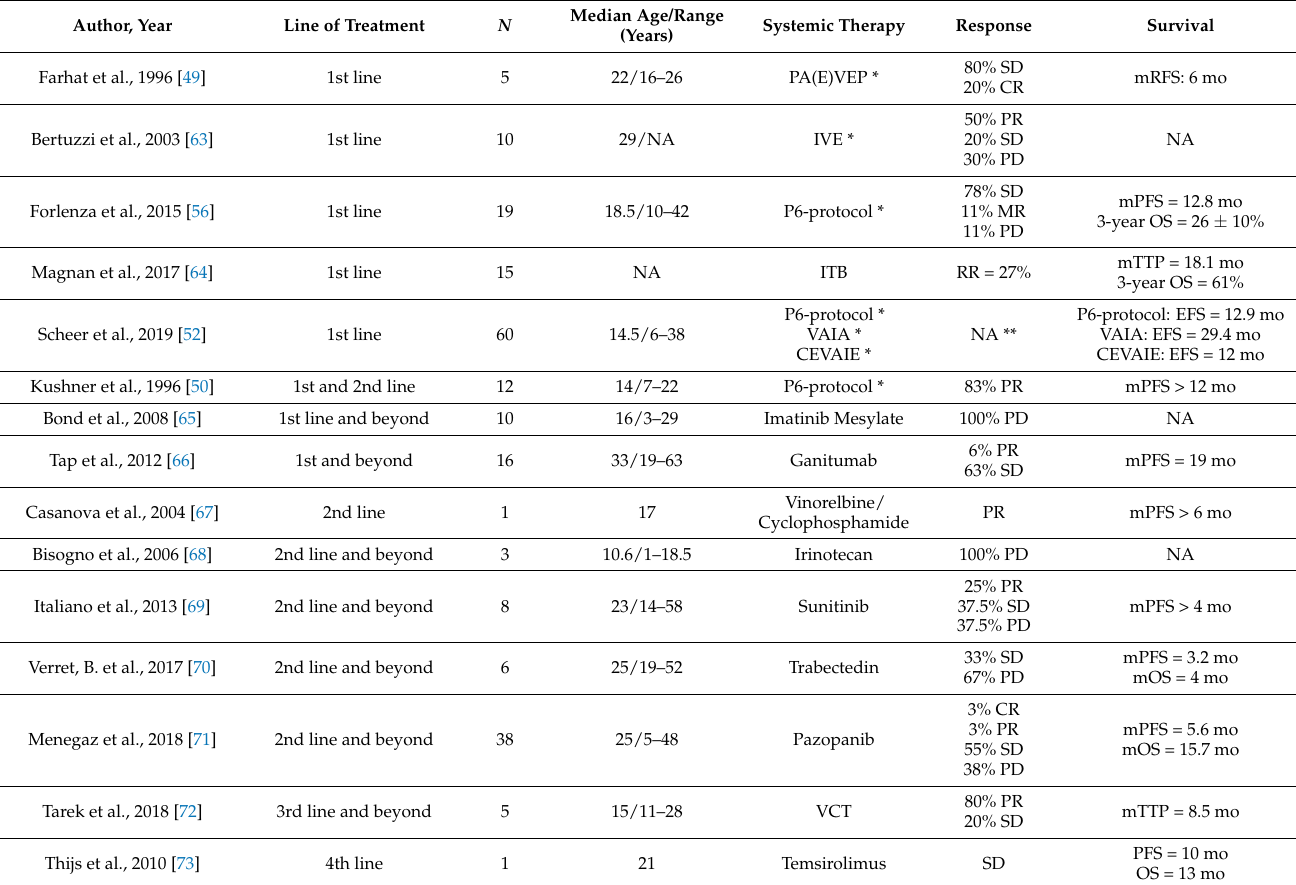
Table 3. Selected studies evaluating the efficacy of systemic treatments in patients with DSRCT according to the line of treatment.